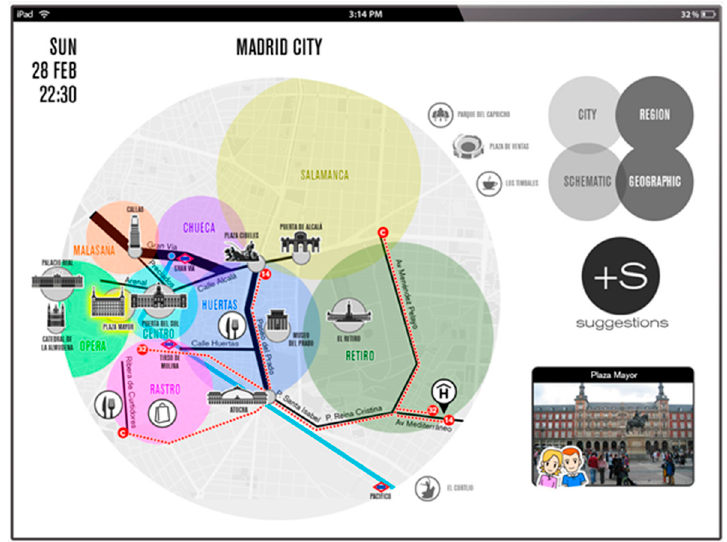
Figure 12. Map created for tourist T2 (Explorer), presenting a summary of places visited during the stay in Madrid. Drawn upon the sketch maps of the Explorers, the map design includes a large number of features, with hubs and zones (colored circles), and applies a coordinated reference system. If tourist T2 selects the suggestions button, several recommendations will be shown on the same map, changing the previous content to grey, and displaying the new one in color. The suggestions will consider the interests of tourist T2, as well as public transport lines, timetables, and weather forecasts. Maps for T1 and T2 include features from the collective conception of tourists in Madrid and customized icons (guideline 1). However, the number and type of features, as well as the reference system, is adjusted to the type of tourist (guideline 2). Finally, the elements included in each specific map adapt to the spatial task (context of use) and the individual’s interests and knowledge, and evolve over time, as the cognitive maps also do, in line with the tourist’s experience in the city (guideline 3). In the case of tourist T2 had a conditioned experience because, e.g., s/he had come to Madrid to take part in a conference, s/he would have moved as an Explorer in the free time, but his/her tourism experience would have been restricted and influenced by the amount of free time available and the location of the conference. Thus, the map presented in Figure 12 would have contained fewer elements but retained the same reference system. It would also have included the location of the conference, the transport lines used to go there, and the suggestions would take into account the location of the conference and transport timetables. We conducted a basic evaluation test of the map prototypes illustrated in Figures 11a and 12 with 3 Guided tourists and 3 Explorer ones, respectively. All participants valued the clarity of the information in the map design. Some tourists appreciated the usefulness of the map and highlighted that the icons helped greatly in remembering places of the city. Two tourists observed that they were accustomed to using conventional maps and that the personalized map caused them some worry and uncertainty. However, one of these tourists suggested the option to switch between personalized and conventional maps, so that users could visually compare them and feel more comfortable when using the personalized map. 5. Conclusions The aim of this work was to reinforce map users’ mental links between maps and places in a city though the use of personalized maps. The maps were designed from a user-centered perspective that empower the users’ roles in the map design process, in which users were more than mere map readers, and cognitive aspects influenced by their experience as map users in the city were also considered. We proposed the design of “cognitively aware” personalized maps by adaptation, bearing in mind the type of map user and the context for its use.